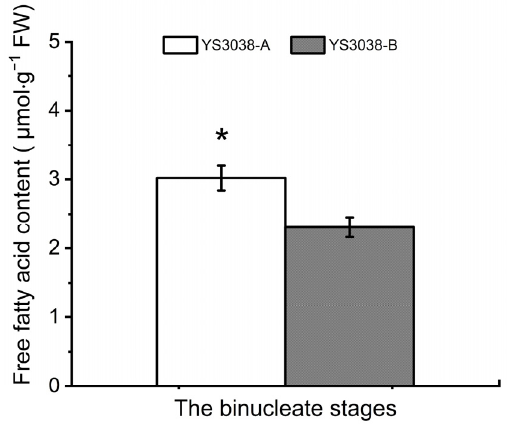
Figure 4. Free fatty acid content in YS3038-A and YS3038-B anthers. Data represent the mean and standard deviation of three replicates. Significant differences were determined by Student’s t -test (* p < 0.05).